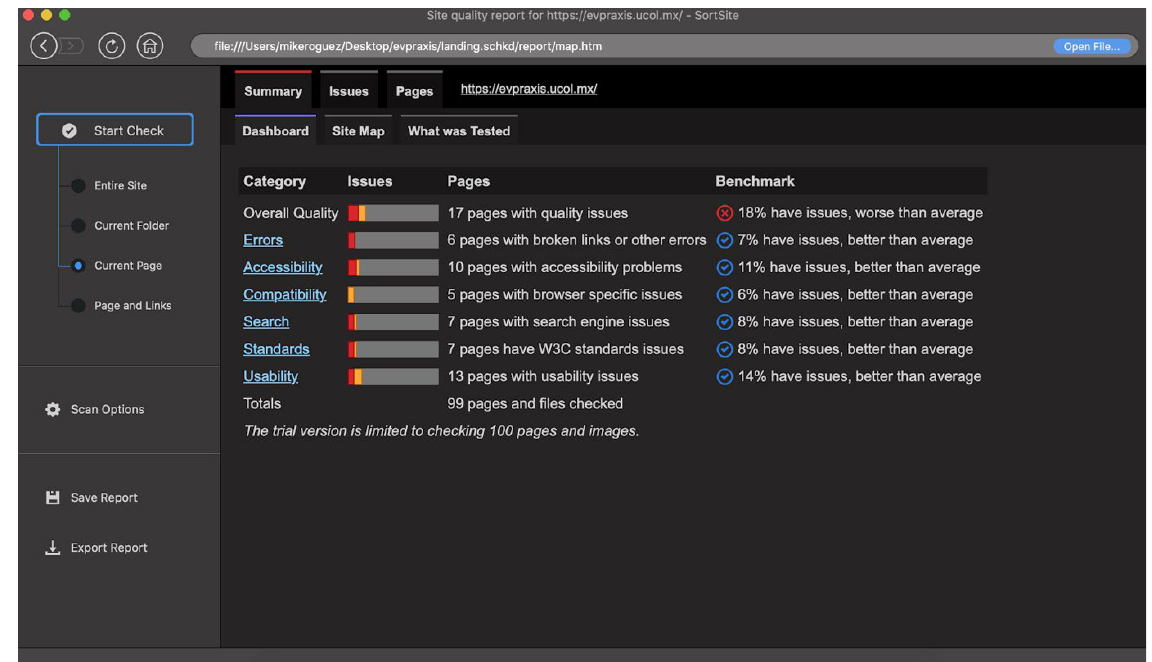
Figure 10 . Results of the Accessibility validation report for EvPraxis (landing